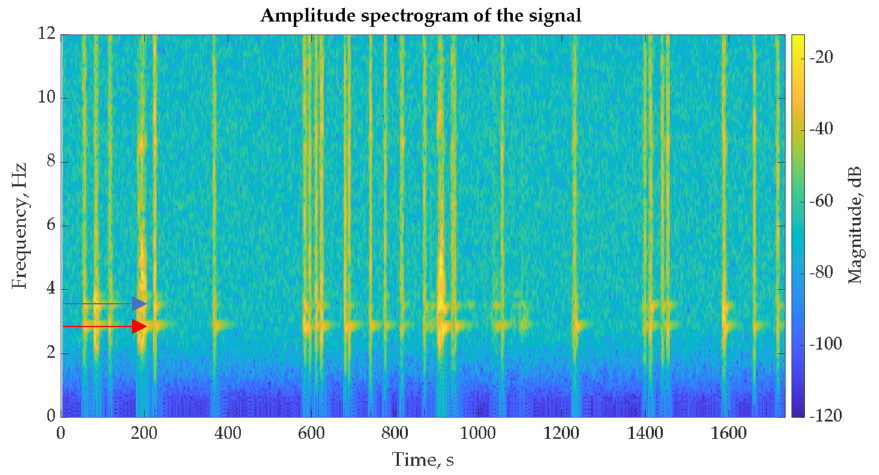
Figure 15. Short Time Fourier Spectrum of sensor 5 at vertical axis.